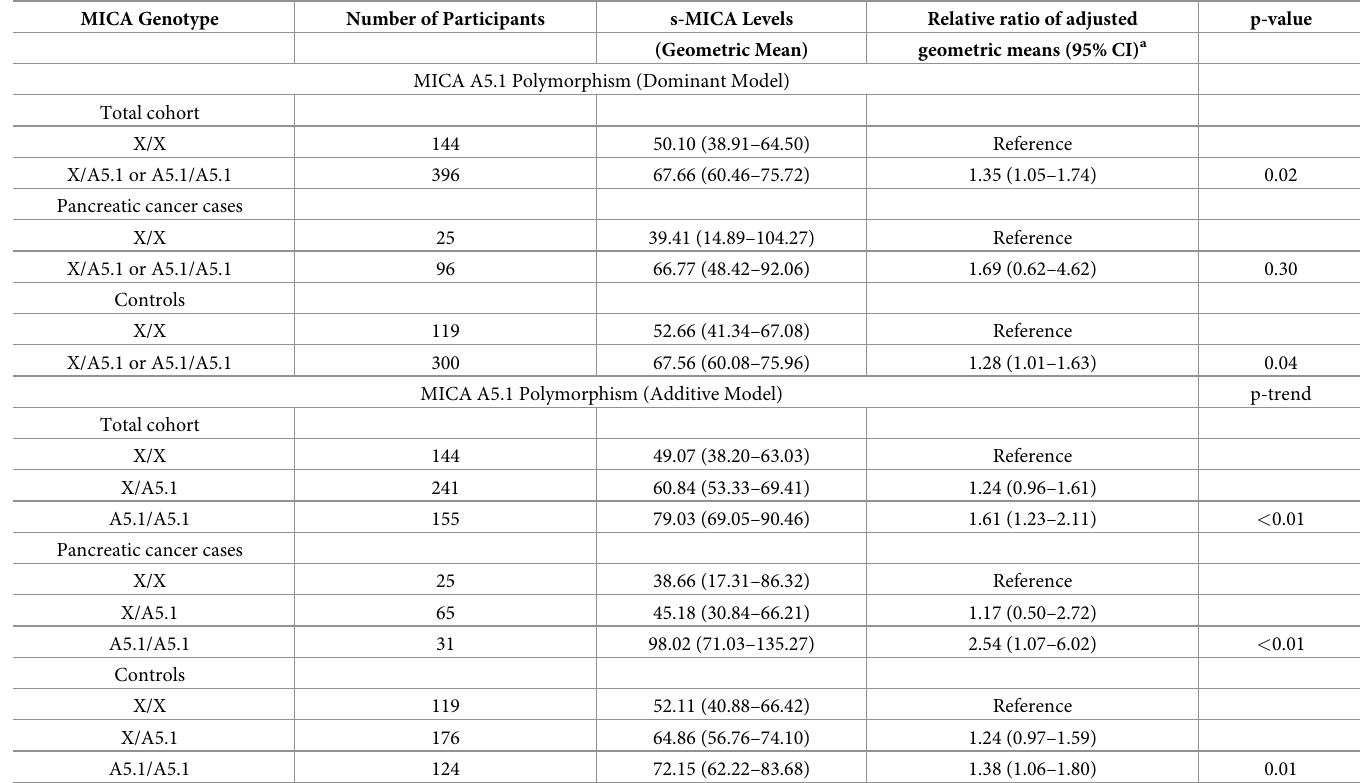
Table 2. Association between circulating MICA levels (s-MICA) and the genotype distribution of the MICA A5.1 polymorphism (dominant and additive